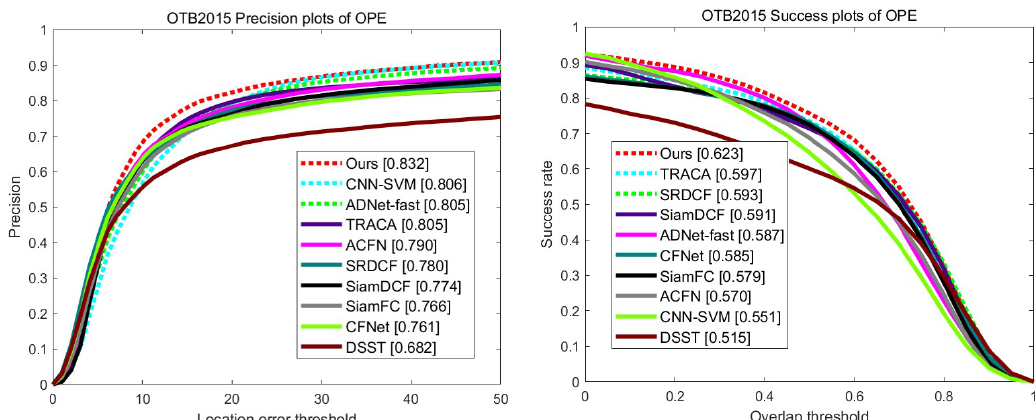
Figure 7. The precision and success plots on the OTB2015 [29] dataset.